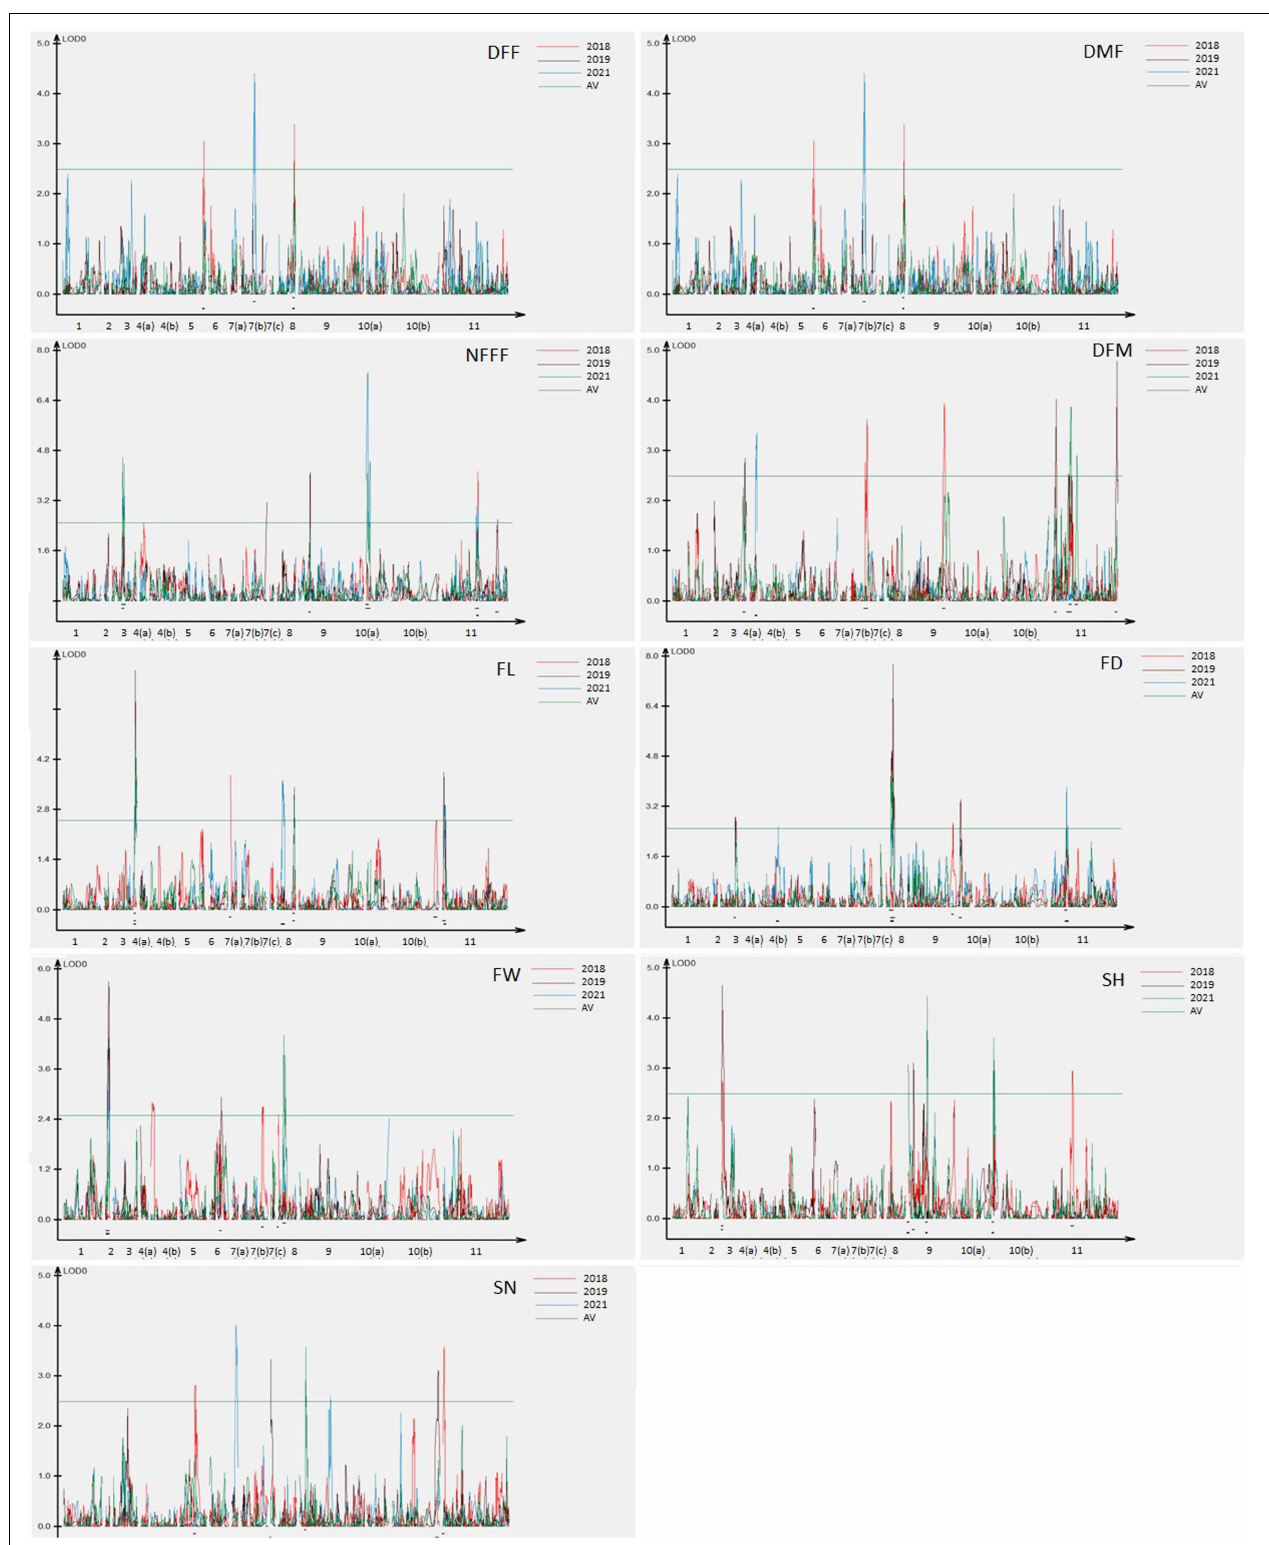
FIGURE 2 | Quantitative trait locus (QTL) detected for nine horticultural traits DFF, DMF, NFFF, DFM, FL, FD and FW, SH and SN detected in environments 2018, 2019, 2021, and AV. Plots indicate the genetic coordinate on the x -axis and logarithm of the odds (LOD) score on the y -axis of detected QTLs.